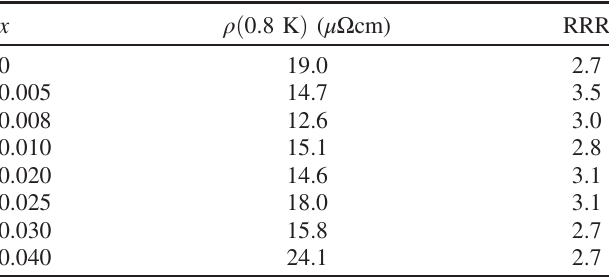
TABLE I. Resistivity parameters summary.